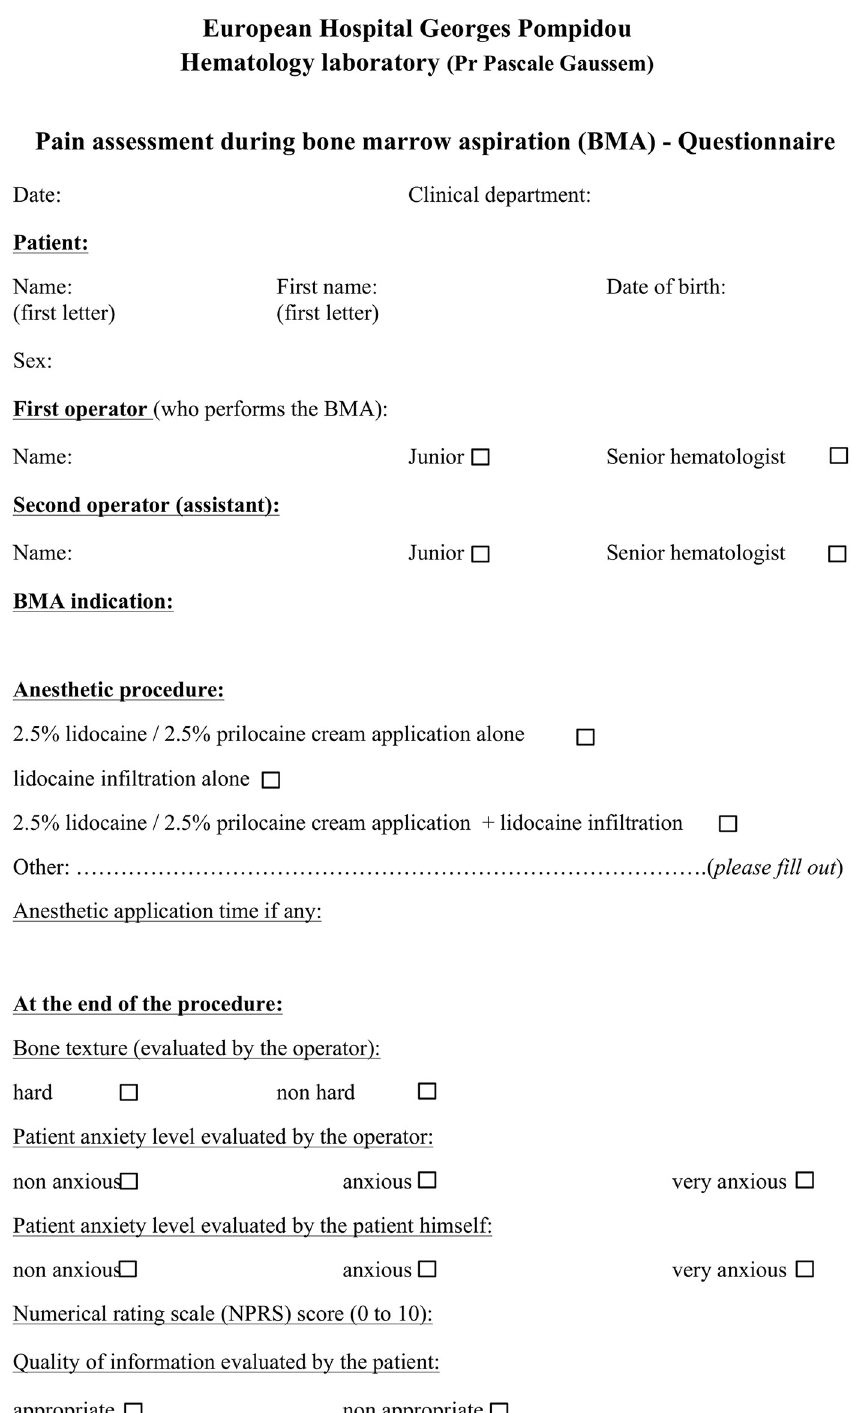
Fig 1. Questionnaire on pain assessment during bone marrow aspiration